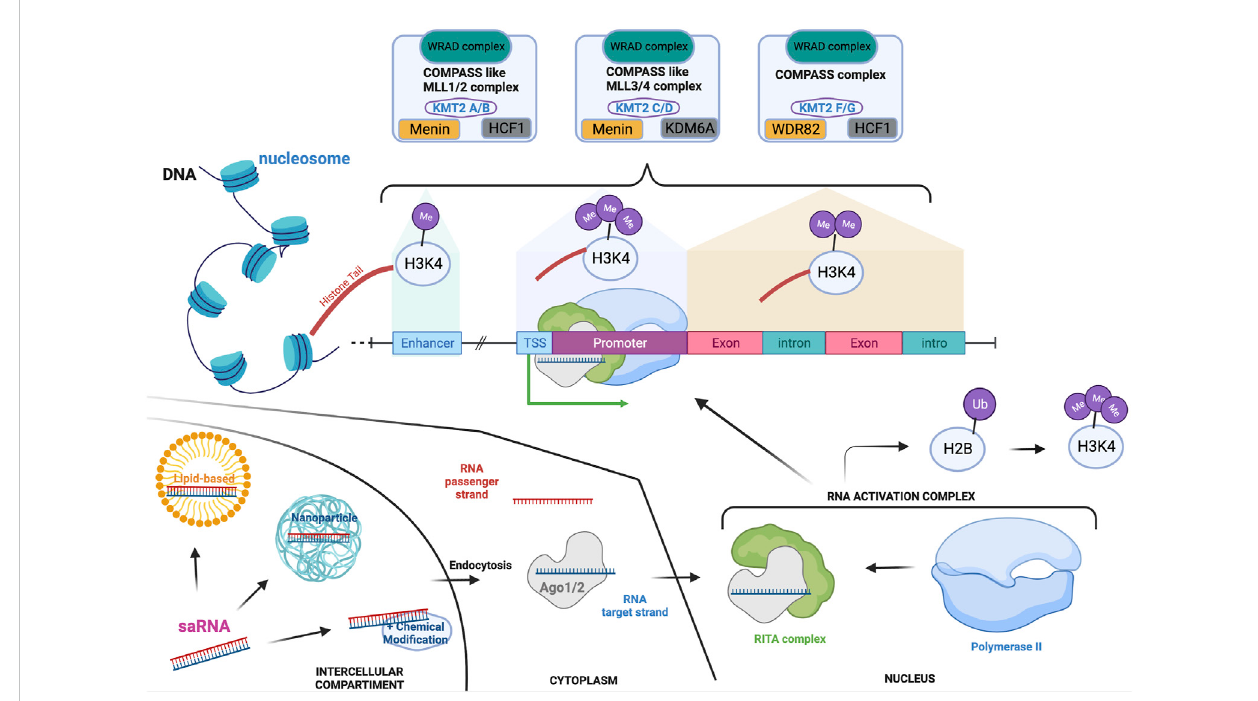
FIGURE 1 KMT2-associatedcomplexesandsaRNAmodeofactioninthetranscriptionmachinery.Transcriptionactivationisauniquemechanismthatisinpart controlledbytheadditionofmono-(atenhancer),di-(atactivelytranscribegenelocus)ortri-(atpromoter)methylationonthelysinefourofthehistone3. These methylations are mediated by the COMPASS and COMPASS-like complexes which are formed by the association of speci fi c subunits. Each of the complexes hold a common subunit called WRAD to which associate speci fi c subunits: Menin and HCF1 to generate the COMPASS like/MLL1- 2 complexes; Menin and KDM6A for the COMPASS like/MLL3-4 complex; HCF-1 and WDR82 for the COMPASS complex. saRNAs are synthetic RNA probes which enable transcription activation. Double-stranded saRNA can be delivered by various vehicles to the target cell, such as lipid-based or nanoparticletechnology.Afterendocytosis,thesingleRNAtargetstrandisloadedontheAgoproteinbeforetranslocatingtothenucleus.TheloadedAgo proteinassociates withtheRITA complexto recruitpolymerase IIandform theRNAactivation complexthat isguided tothepromoter ofthetarget gene. Thisisassociatedtoubiquitinationofthehistone2 bwhichthen triggersH3K4me3,enhancingtheactivation oftranscription.IftargetingHKMTs,thiswill increment their transcription and transduction enabling mono-, di- or tri-methylation of speci fi c lysine (K) on histone (H) tails. Depending on the lysine localization, these post-translational modi fi cations will repress or activate speci fi c genes. Created with